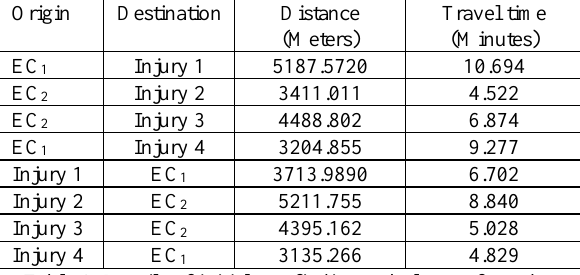
Table 2. Details of initial wayfinding ambulances from the